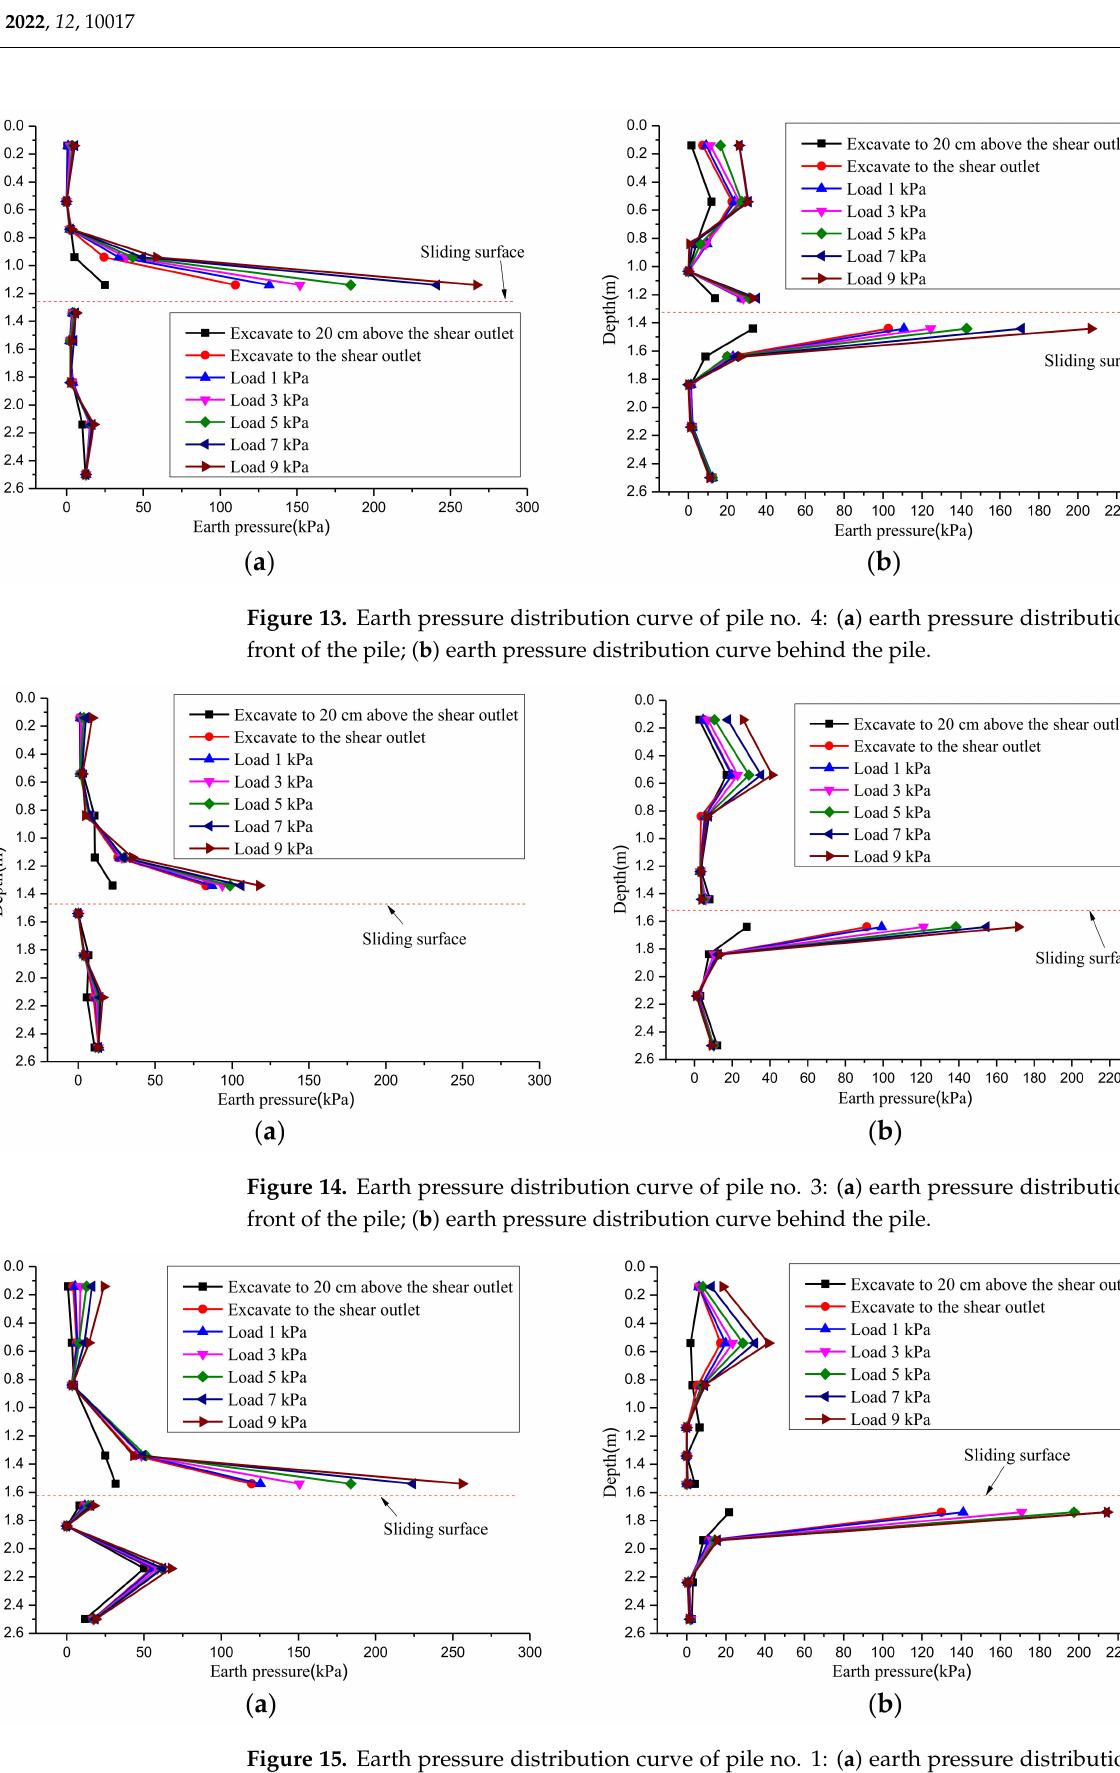
Figure 15. Earth pressure distribution curve of pile no. 1: ( a ) earth pressure distribution curve in front the pile; ( b ) earth pressure distribution curve behind the